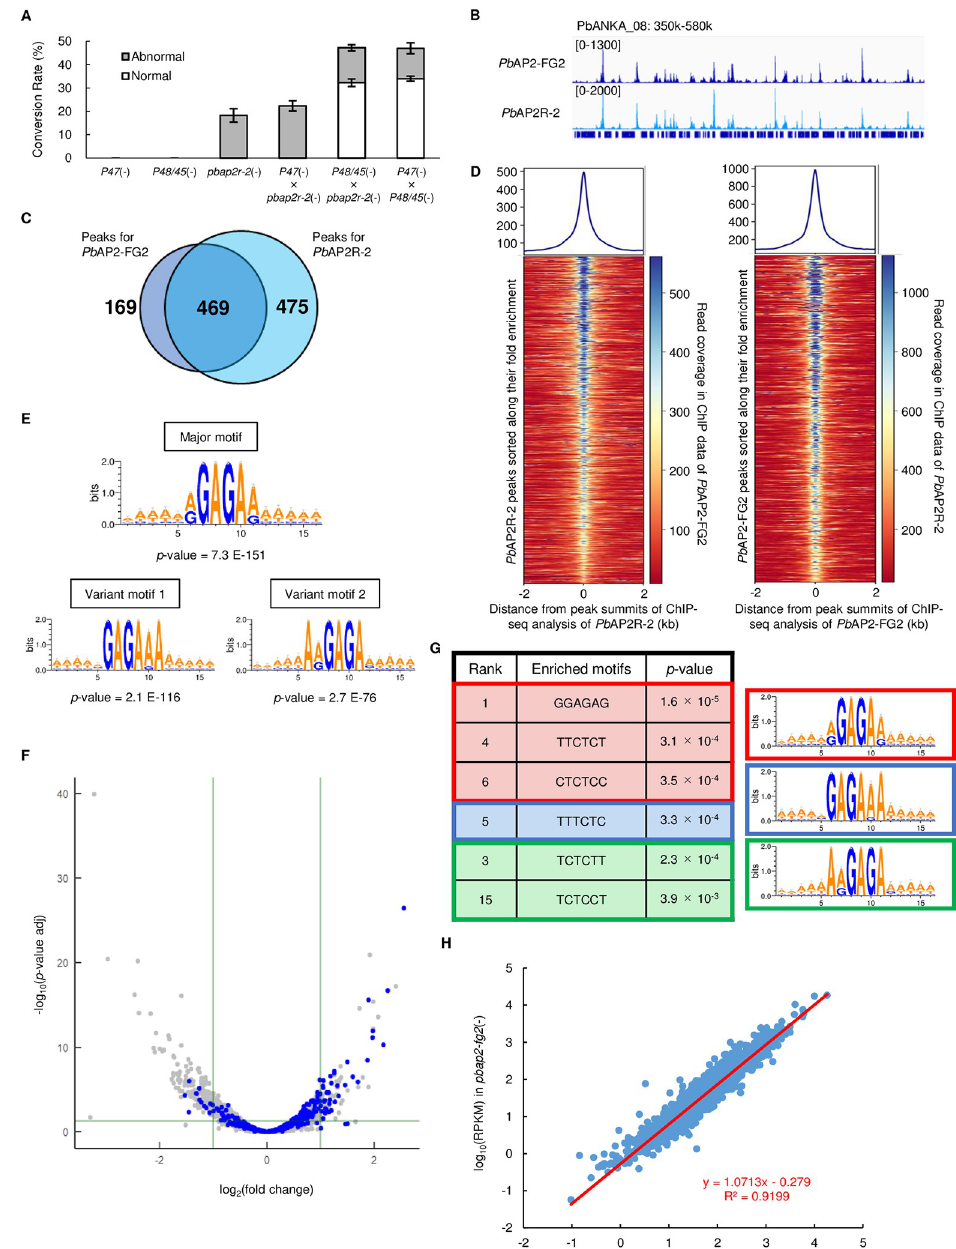
Fig 6. ChIP-seq of Pb AP2R-2 and differential expression analysis between WT and pbap2r-2 (-). (A) Cross- fertilization assay among pbap2r-2 (-), p48/45 (-)and p47 (-).The number of normal and abnormal ookinetes are indicated as white and grey bars, respectively. Error bars indicate the standard error of the mean (n = 3). (B) IGV images showing peaks identified in the ChIP-seq analysis of Pb AP2-FG2and Pb AP2R-2.Read coverage for the ChIP data is shown. (C) A Venn diagram showing the overlap between peaks detected in the ChIP-seq of Pb AP2-FG2and Pb AP2R-2.(D) Heat maps showing coverage in ChIP-seq of Pb AP2-FG2at Pb AP2R-2peaks (left) and coverage in ChIP-seq of Pb AP2R-2at Pb AP2-FG2peaks (right). Peak regions are aligned in ascending order of their fold enrichmentvalue. Graphs on top of the heat maps show the mean coverage of all peak regions. (E) Motifs enrichedwithin 50 bp from peak summits identified in the ChIP-seq of Pb AP2R-2.The logos were depicted using WebLogo 3. (F) A volcano plot showing DEGs in pbap2r-2 (-) compared to WT. Blue dots represent the target genes of Pb AP2-FG2.A horizontalline indicates a p -valueof 0.05, and two vertical lines indicate log 2 (Fold Change) of -1 and 1. (G) Six-bp DNA motifs enriched within upstream region of genes upregulated in pbap2r-2 (-).(H) A scatter plot showing relationship between log 10 (RPKM) in pbap2-fg2 (-)and pbap2r-2 (-) for each gene. A red line indicates a linear approximation of the